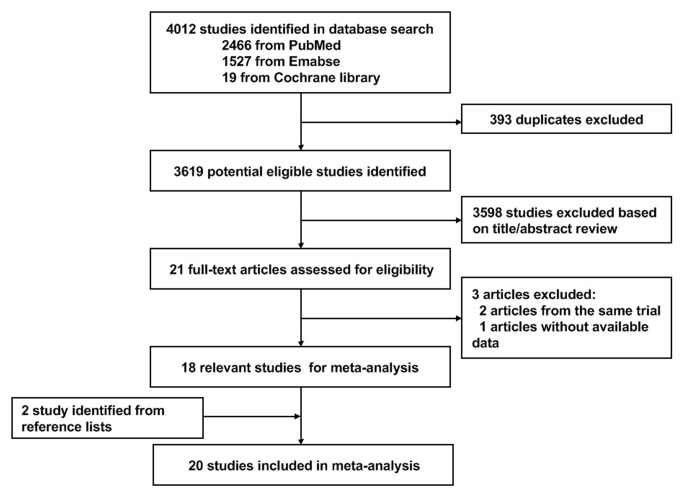
Flow diagram of screened, excluded, and analysed publications.